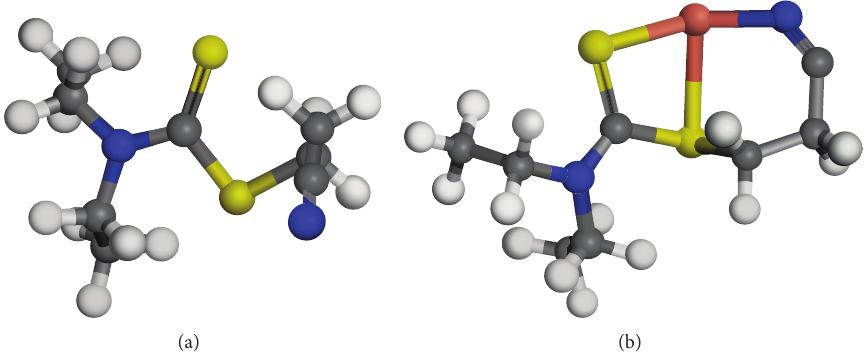
Figure 6: The molecular structure of NND and NND + Cu 2+